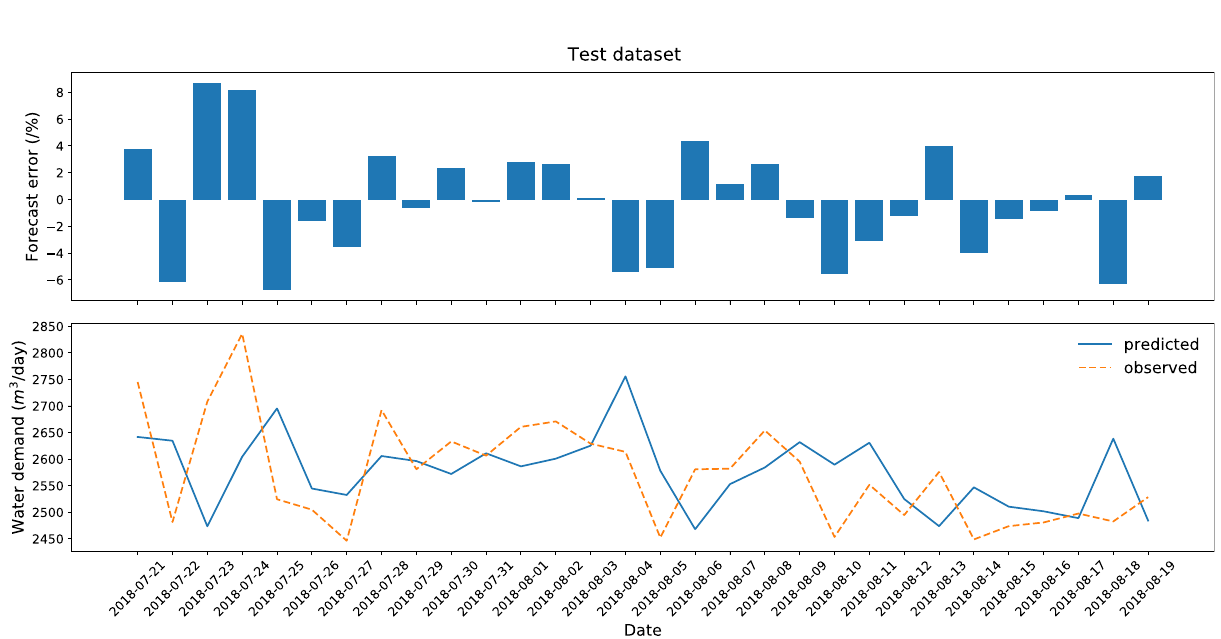
Figure 5. Research results for the worst variant of forecasting—test dataset (dataset no.